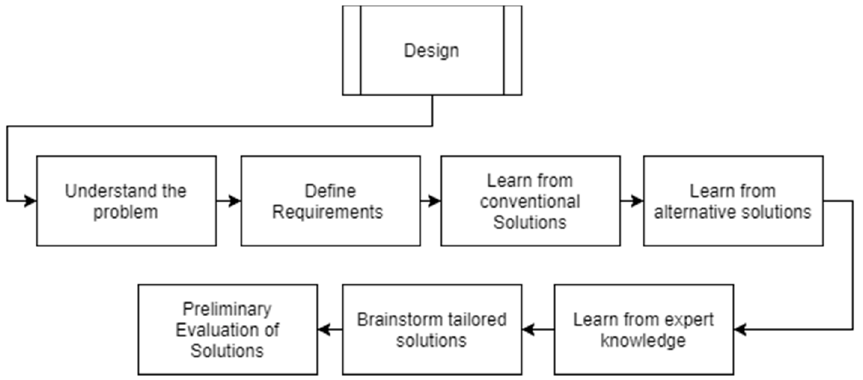
Figure 10. The Design Process broken down to its components.